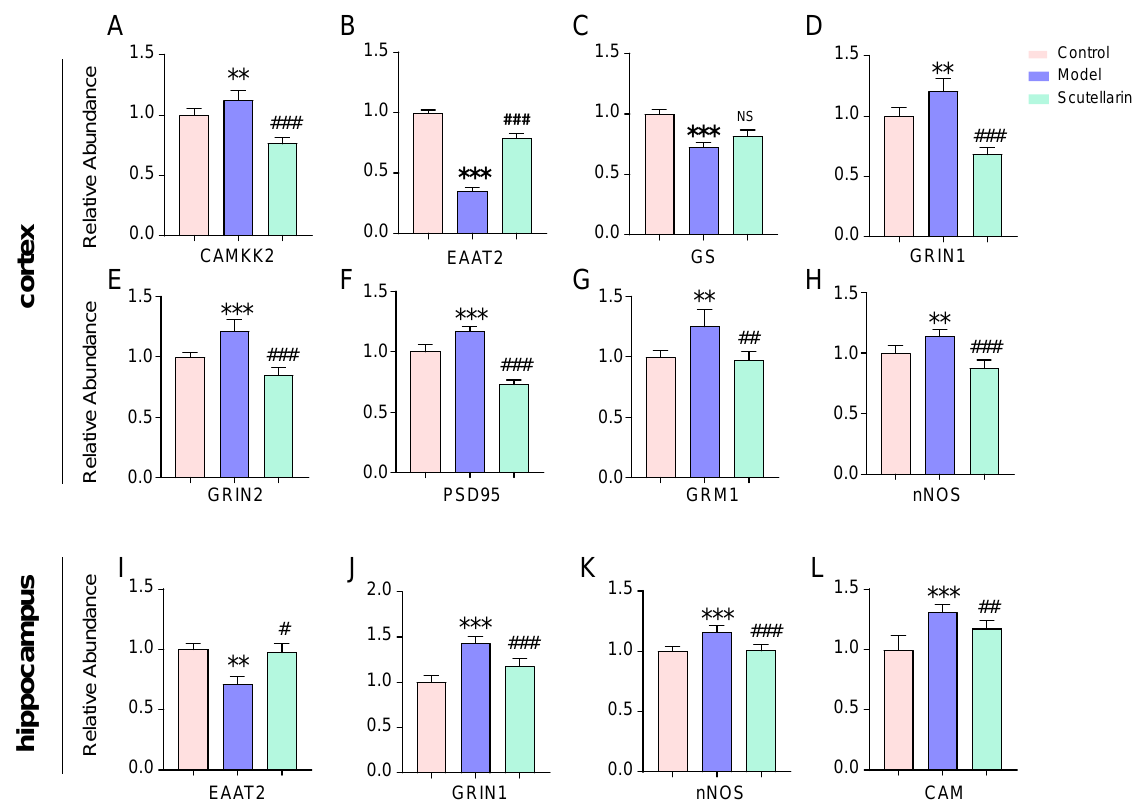
Figure 3. Targeted quantification of glutamatergic signaling-related proteins in the brains of MCAO/R model rats at 12 h after reperfusion. Scutellarin exerts significant reparations on CAMKK2 ( A ), EAAT2 ( B ), GRIN1 ( D ), GRIN2 ( E ), PSD95 ( F ), GRM1 ( G ), and nNOS ( H ) in cortex, but its effect on GS ( C ) is not statistically significant. Scutellarin exerts significant reparations on EAAT2 ( I ), GRIN1 ( J ), Nnos ( K ) and CAM ( L ) in the ischemic hippocampus. Data are presented as mean ± SD , t-test vs. control group: ** p < 0.01, *** p < 0.001; vs. model group: # p < 0.05, ## p < 0.01, ### p < 0.001. 2.3. Changes in the Metabolic Profile of the Ischemic Brain in Acute Phase and Scutellarin Regulation Table 2 . The characteristic peptides of targeted proteins. To investigate the alteration in the metabolic profile of the brains of individuals suffer- ing from acute ischemia, metabolomics was applied to both the cortical and hippocampus tissues of rats. Compared to the control group, 612 different metabolites were identified in the ischemic cortex of the model group, 341 of which were significantly downregulated and 271 were upregulated (Figure 4A). In the hippocampus, a total of 212 differentially expressed metabolites were identified between the control group and the model group, of which 91 metabolites were significantly downregulated and 121 metabolites were upregu- lated (Figure 4C). In both the cortex and hippocampus, multiple amino acid metabolism pathways were enriched (Figure 4B,D). The results indicated that amino acid metabolism could be a potential target for acute-phase ischemia